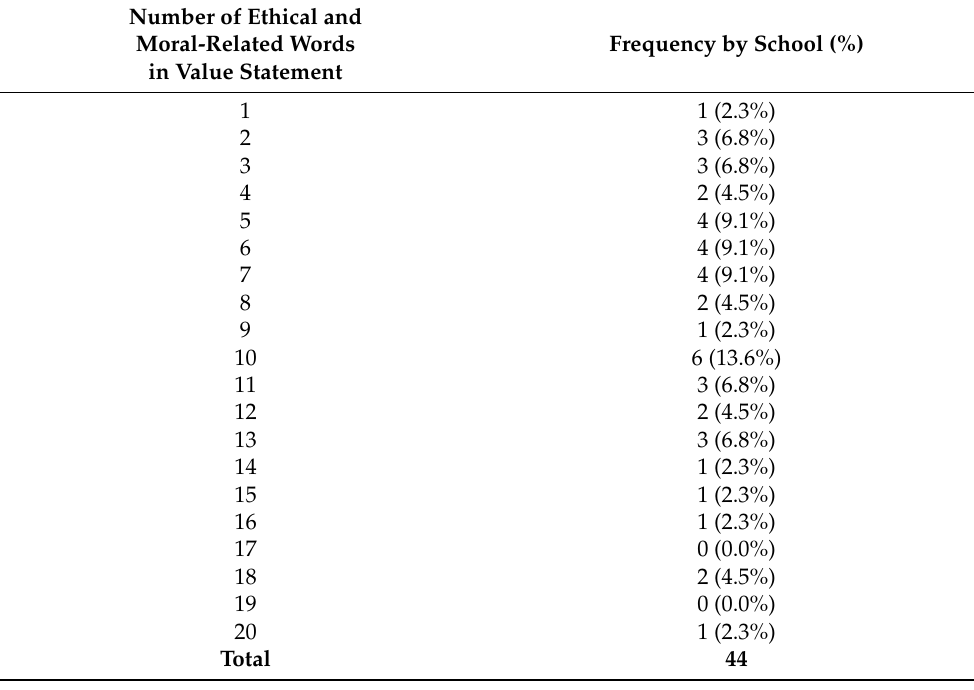
Table A3. Frequency of Morally Relevant Words in value statements. Number of Ethical